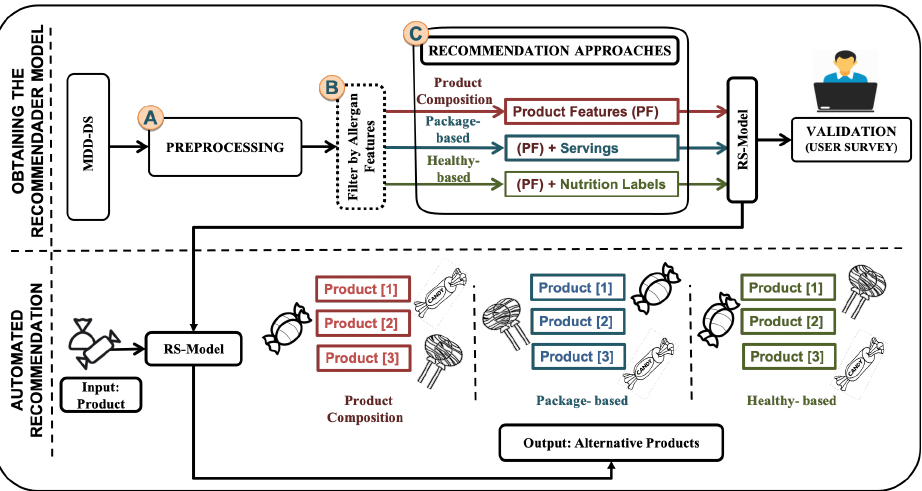
Figure 1. Description of the proposed model definition and evaluation.